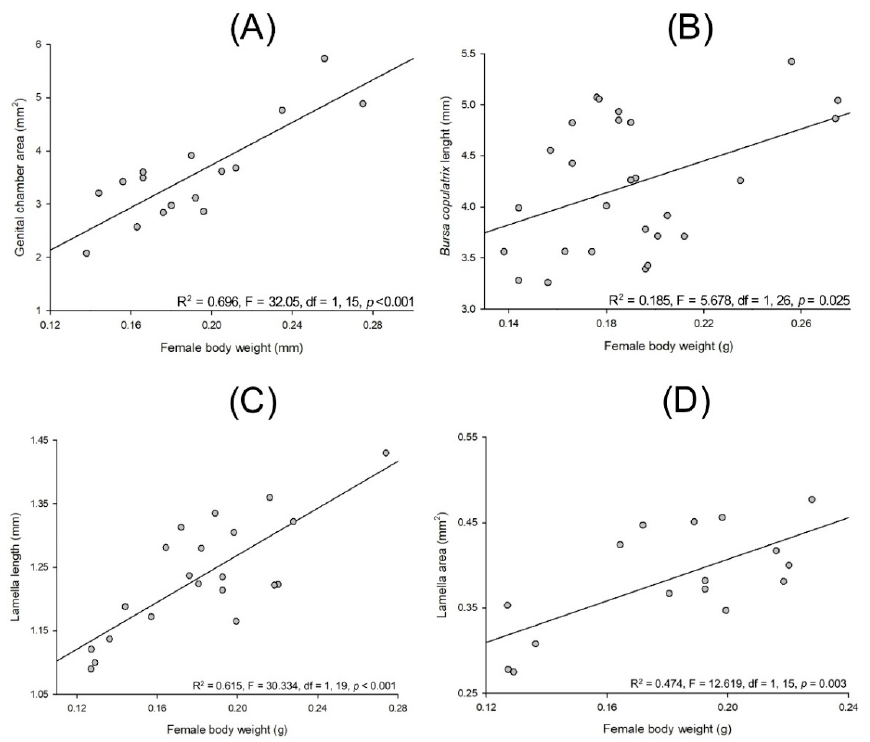
Figure 14. Relationship between body weight and body parts on Cyclocephala barrerai females: body weight and ( A ) genital chamber area, ( B ) bursa copulatrix length, ( C ) lamella length and ( D ) lamella area.